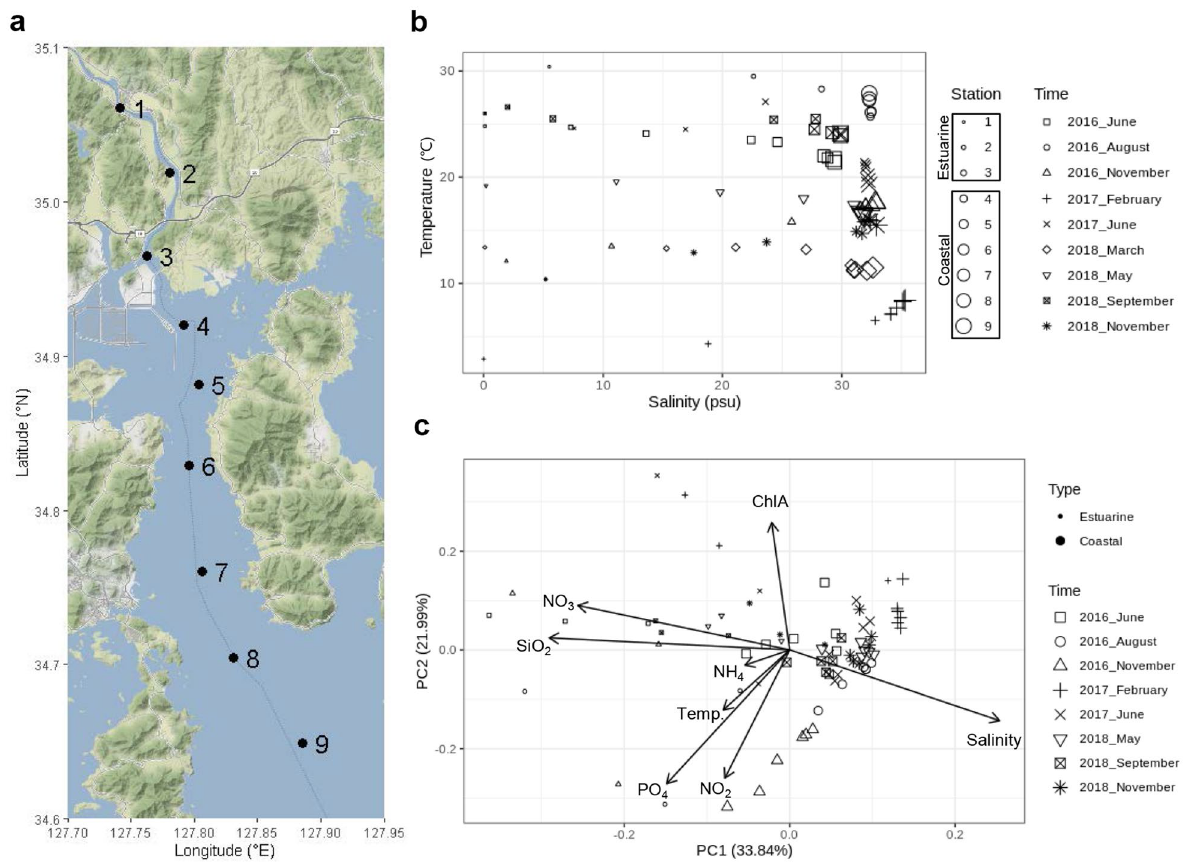
Figure 1. Environmental heterogeneity in GB waters. ( a ) Sampling stations were drawn by Google Map using the ggmap package 58 in R. ( b ) Spatiotemporal variation of GB waters in T-S diagram and ( c ) its statistical separation with environmental factors supported by principal component analysis. Values of environmental parameters in this study were listed in Supplementary Informationn 1 (excel